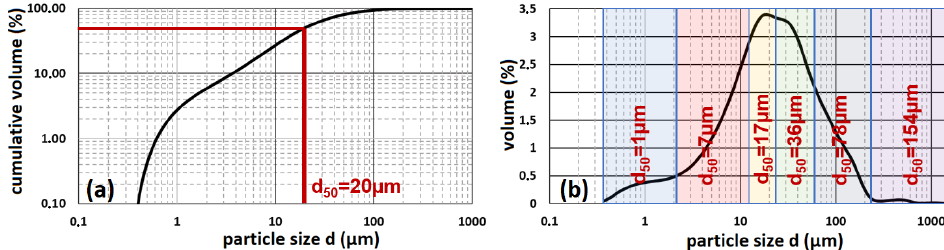
Figure 3. Sediment characteristics in the Rove Canal per particle size, from [2]: ( a ) cumulative volume (%), ( b ) volume (%). Colored rectangles represent the six ranges of particle sizes.